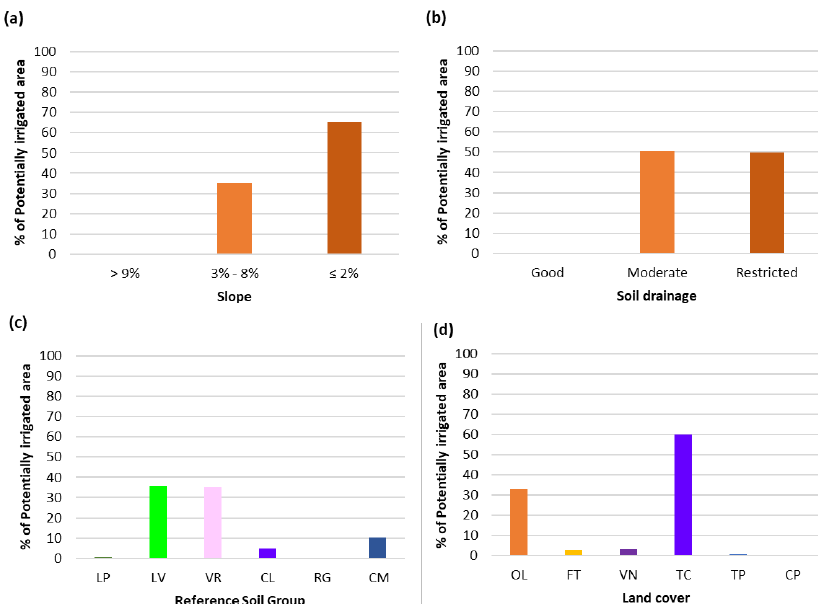
Figure 8. Percentages of Moderate Risk of Salinization areas per slope class ( a ), drainage class ( b ), soil reference group ( c ) and land cover ( d ). LP—Leptosols; LV—Luvisols; VR—Vertisols; CL—Calcisols; RG—Regosols; CM—Cambisols. OL—Olive groves; FT—Fruit trees; VN—Vineyards; TC—Temporary crops; TP—Temporary crops and / or improved pastures; CP—Complex crop patterns.